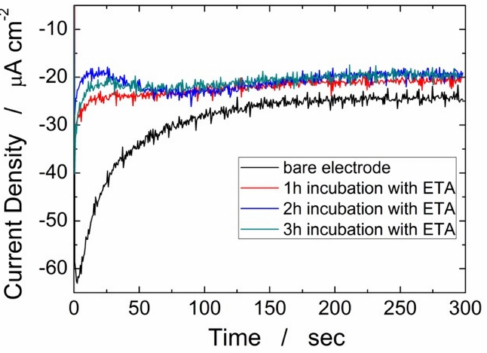
Figure 8. Chronoamperometric curves before and after incubation of ITO-PET/ZnO NRs/rGO with ETA. The ZnO electrode was obtained at − 0.95 V vs. Ag/AgCl for 60 min in a de-aerated solution of 10 mM ZnCl2 and 10 mM NaNO 3 at pH 4.5.